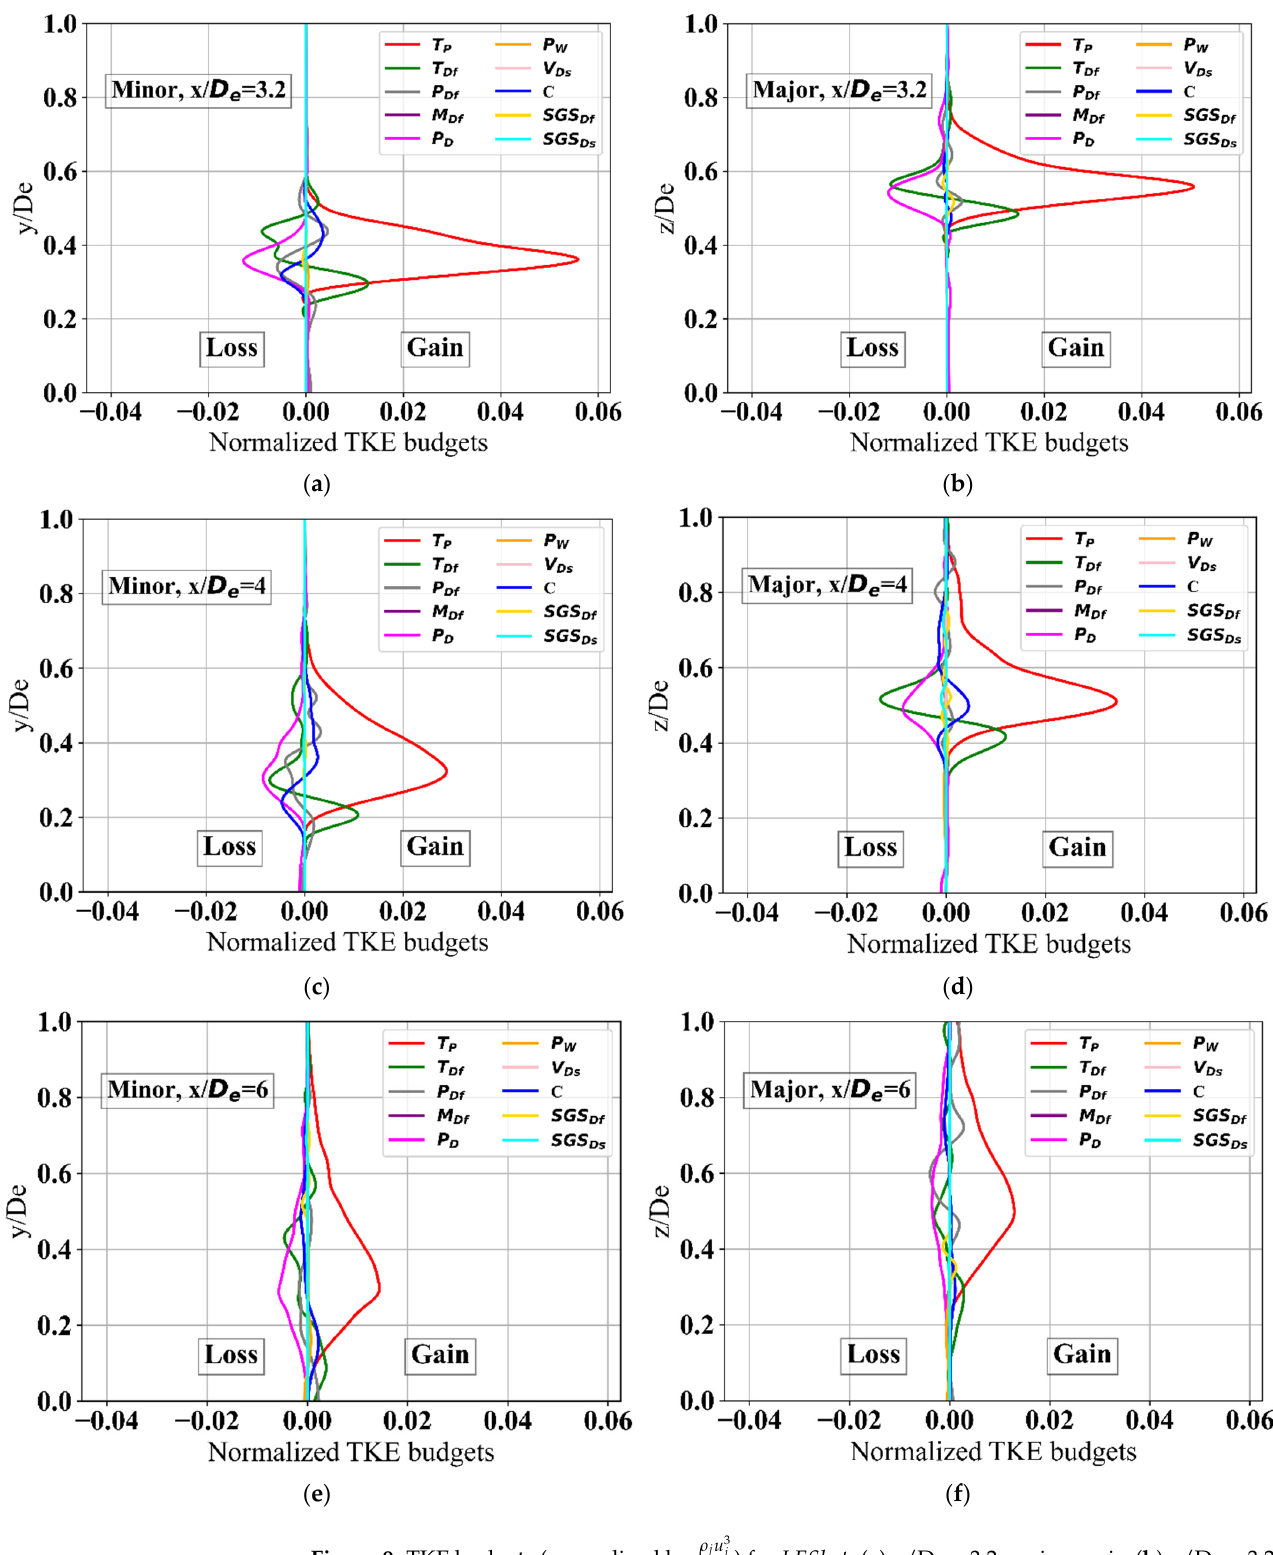
Figure 9. TKE budgets (normalized by major axis, ( c ) x/De = 4—minor axis, ( d ) x/De = 4—major axis, ( e ) x/De = 6—minor axis, ( f ) x/De = 6—major axis.